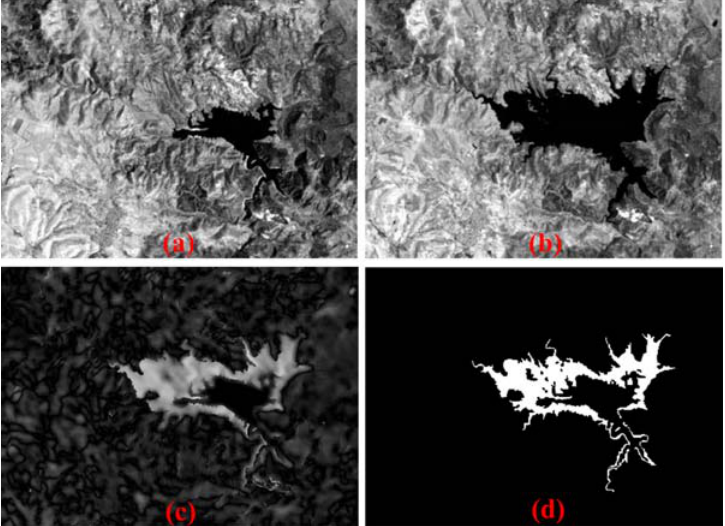
Figure 5. Image of Sardinia Island area in Italy: ( a ) band 4 of the Landsat TM image captured in September 1995, ( b ) band 4 of the Landsat TM image captured in July 1996, ( c ) corresponding CMI based on the proposed approach, and ( d ) reference map of the changed area.